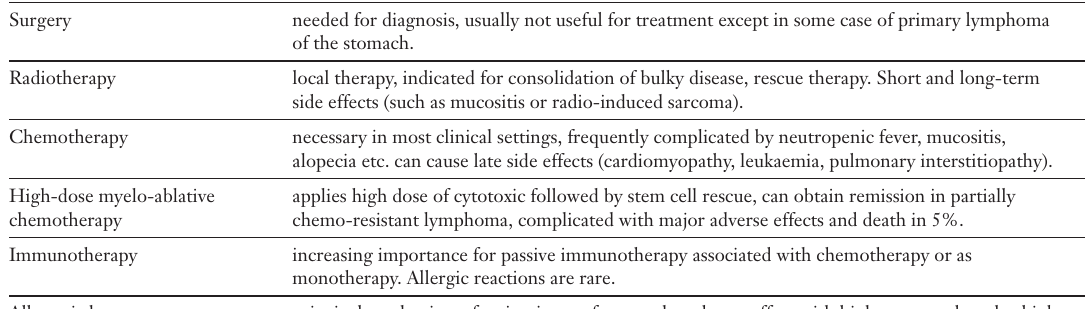
Treatment Strategies for